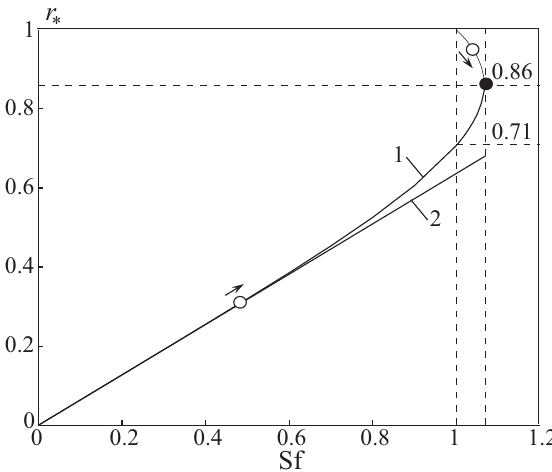
Figure 6. Dependence of the radial coordinate of a singular point on the Stokes and Froude numbers.